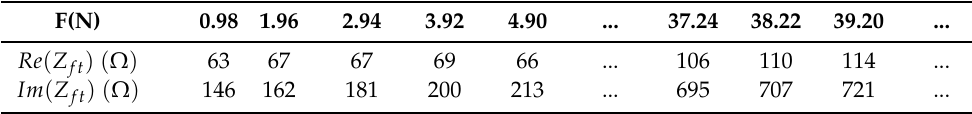
Table 5. The impedance obtained by the